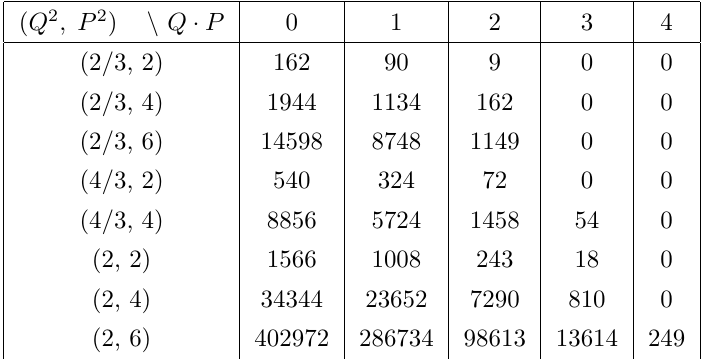
Table 24 . Index of horizon states for the T 6 / Z 3